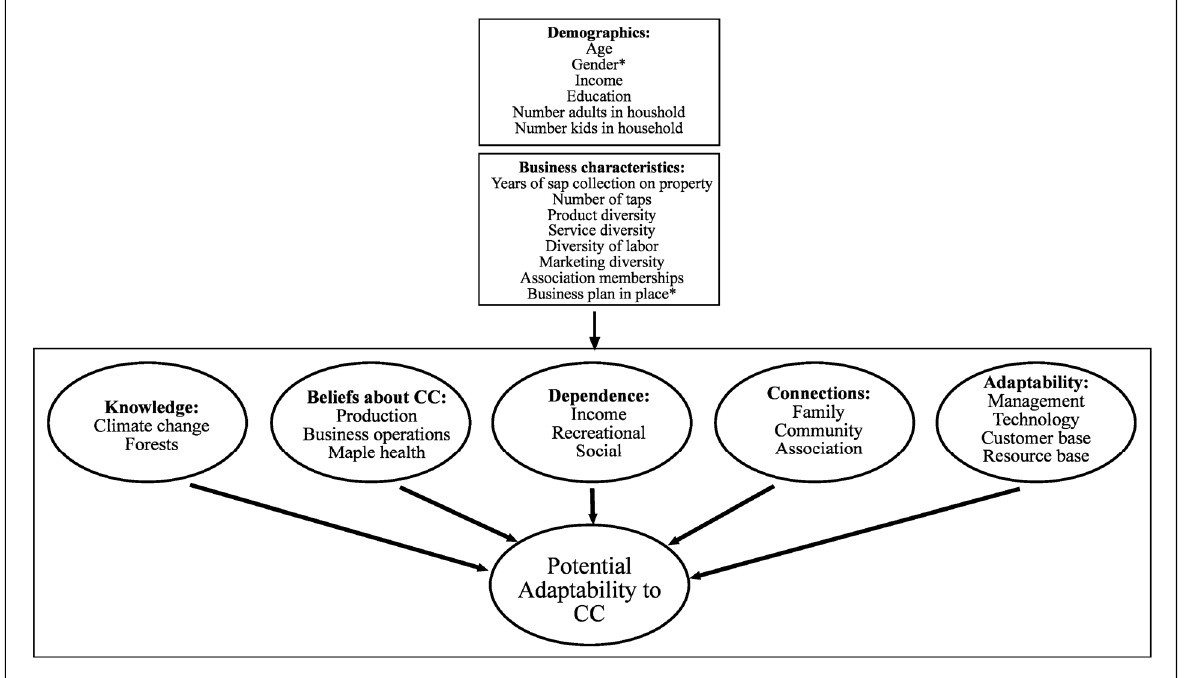
Figure 2. Business Adaptability Model Related to the Potential Impacts of Climate Change (CC) on Maple Production